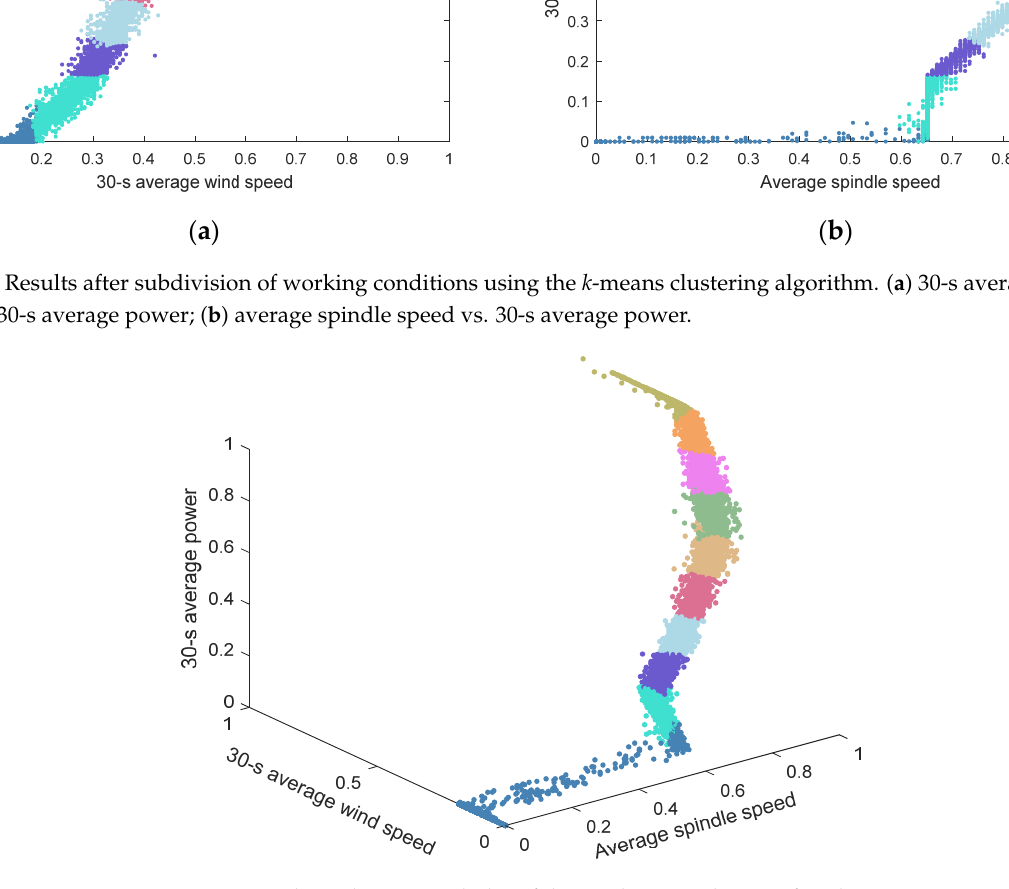
same way and are shown in Table 6.